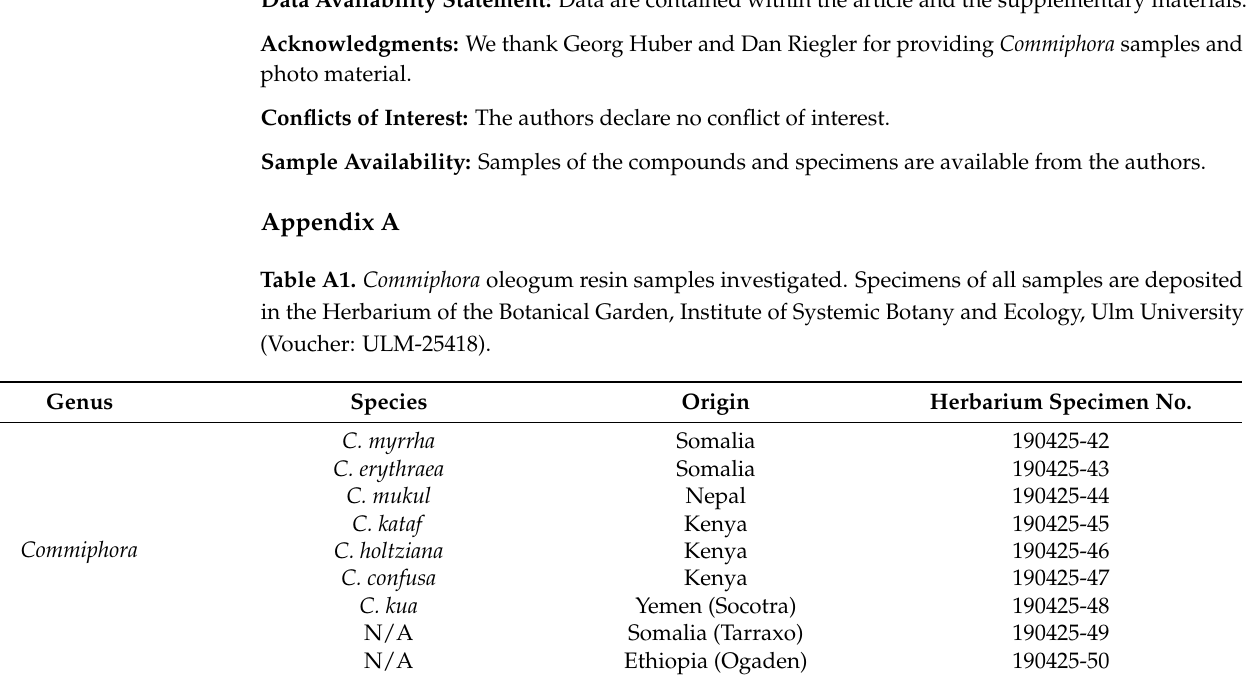
Figure S2: Mass spectra curzerenone, furanoeudesma-1,3-diene, and myrrhone; Table S1: Design of Experiments (DoE) for optimization of chromatographic parameters for selective and rapid gug- gulsterone analysis; Table S2: Quantification of ( E )-guggulsterone, ( Z )-guggulsterone, curzerenone, furanoeudesma-1,3-diene, and myrrhone in Commiphora oleogum resin extracts and botanical drugs; Table S3: Analysis of essential oils in Commiphora oleogum resins; Figure S3: Total wavelength chromatograms (TWC) of Commiphora oleogum resin extracts; Figure S4: Cytotoxicity of Commiphora extracts and essential oils against epidermoid carcinoma cell line A431 and malignant melanoma cell lines RPMI-7951 and SK-MEL-28.